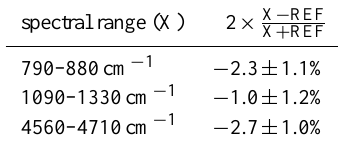
Table 8. Difference (mean and standard deviation) between the H 2 O column abundances obtained in the different spectral regions taking the 2650–3180cm − 1 retrieval as the reference (REF).